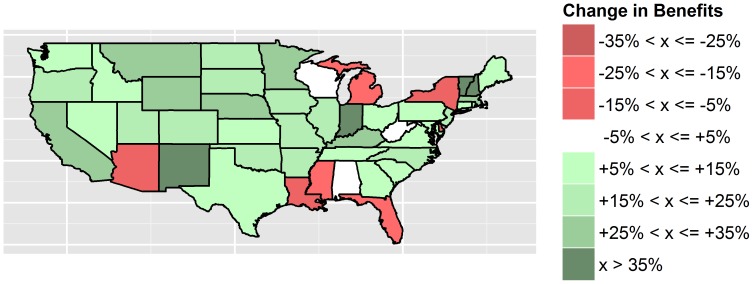
Percentage change in maximum unemployment compensation benefits (adjusted for differences in prices) in US states between 1992 and 2008.